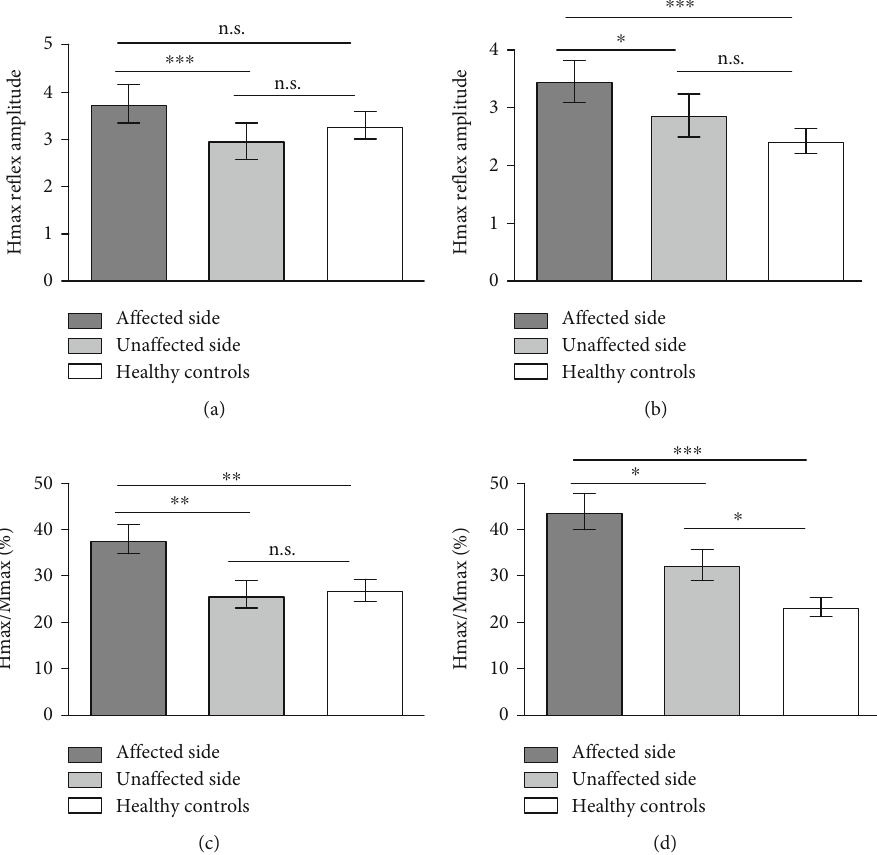
Figure 1: The post hoc multiple comparisons for the H-re fl ex data of the a ff ected side, the una ff ected side, and the healthy control group: (a, c) in the prone position; (b, d) in the standing position. Asterisks indicate signi fi cant di ff erences. ns: not signi fi cant. ∗ p < 0 : 05 ; ∗∗ p < 0 : 01 ; ∗∗∗ p < 0 : 001